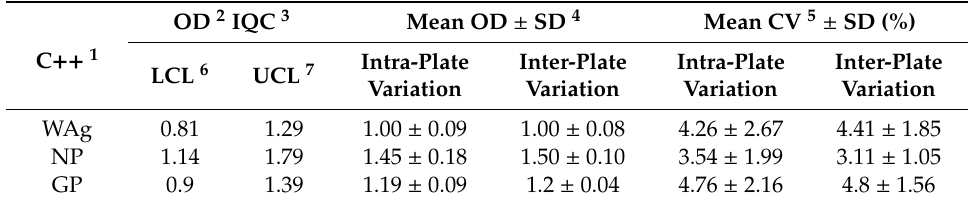
Table 1. Internal control quality data and repeatability estimates for a whole (WAg), nucleocapsid (NP), and glycoprotein (GP) indirect ELISAs for the detection of anti-IgG EBOV antibody in humans. OD 2 IQC 3 Mean OD ± SD 4 Mean CV 5 ± SD (%) C ++ 1 Intra-Plate Inter-Plate Intra-Plate Inter-Plate LCL 6 UCL 7 Variation Variation Variation Variation WAg 0.81 1.29 1.00 ± 0.09 1.00 ± 0.08 NP 1.14